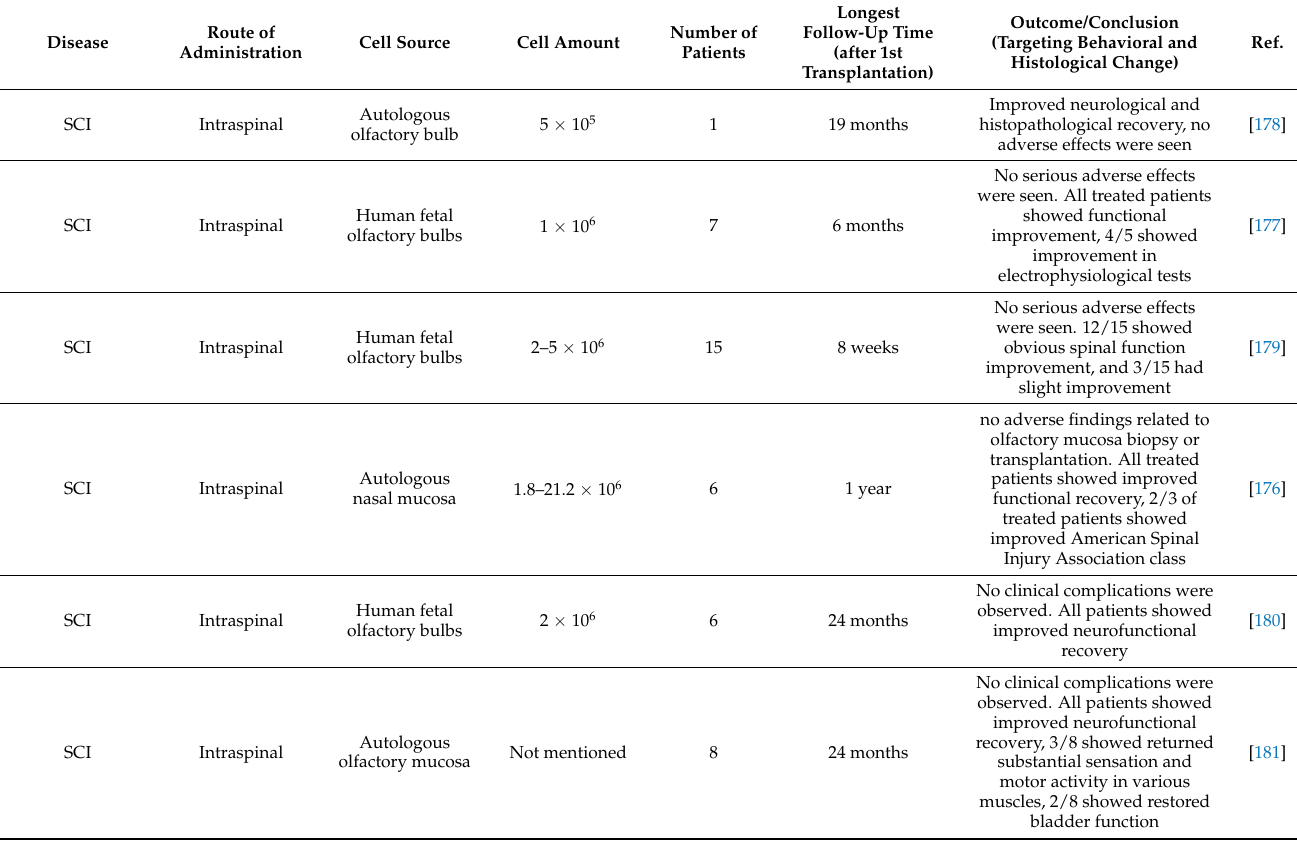
Table 6. Examples of OECs transplantation for neurological disorders in clinical trials (data from PubMed).